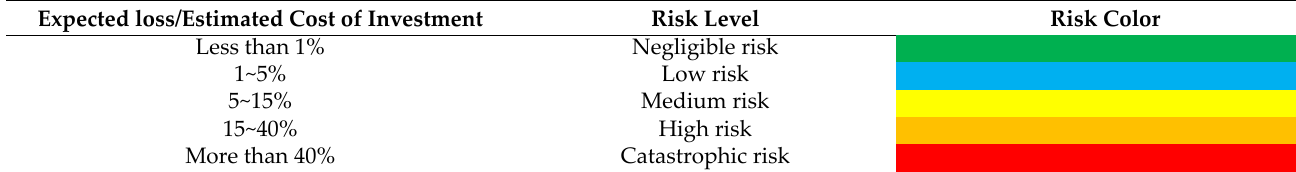
Table 8. Risk level and risk indicators.